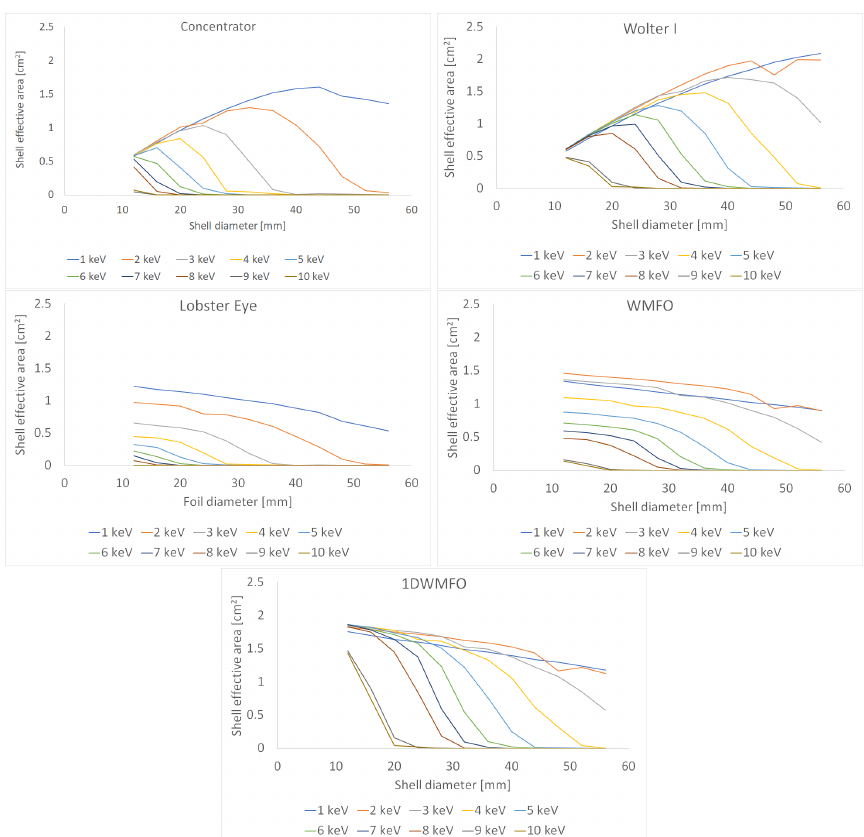
Figure 9. X-ray spectrometer optics effective area calculation for particular shell of diame- ter/dimension respective to optical axis. Final optics properties such as effective area for particular energy are then represented by combination of all shells. In fact, total effective area is represented by simple sum of effective areas of all shells.